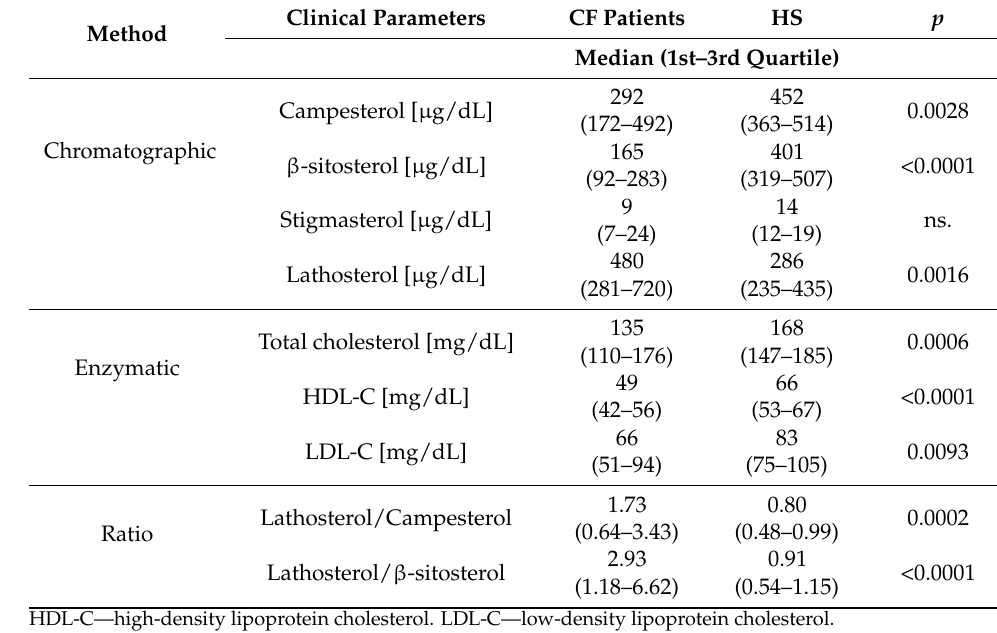
Table 2. Sterols’ concentrations in cystic fibrosis (CF) patients and healthy subjects (HS).